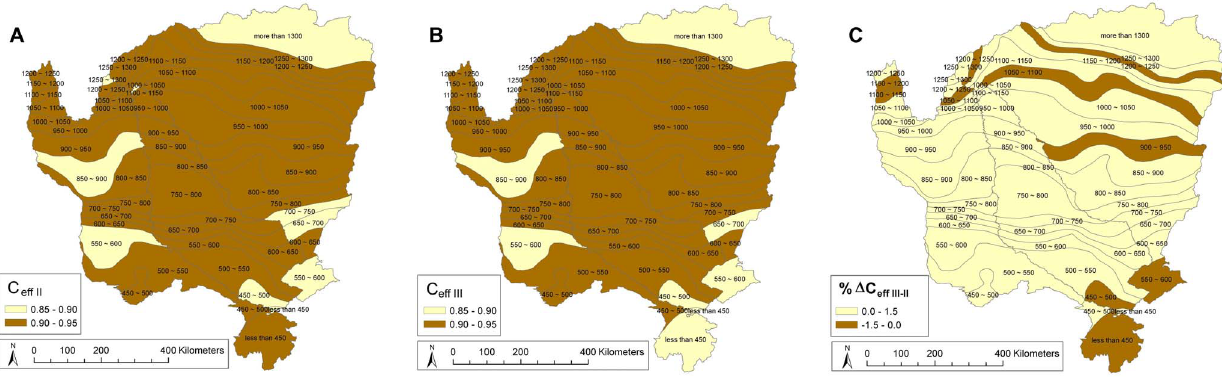
Figure 5. Spatial distribution of goodness-of-fit of the NDVI models. ( A ) final exploratory model II (FSPT) and ( B ) model III (FSPTE) with ( C ) highlighting the changes in goodness-of-fit between model III and II (% D C eff III - II =100*[C eff III - C eff II ]/C eff III ), average value=0.40, max=1.40 and min= 2 0.70. (C eff : Nash-Sutcliffe Efficiency Coefficient).